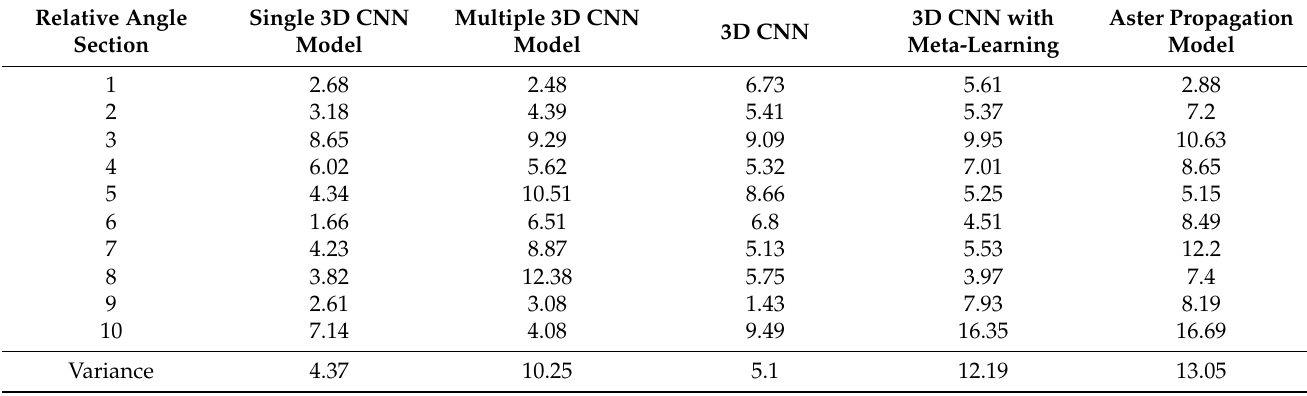
Table 8. Comparison of mean absolute error and error variance according to the horizontal relative angle section.